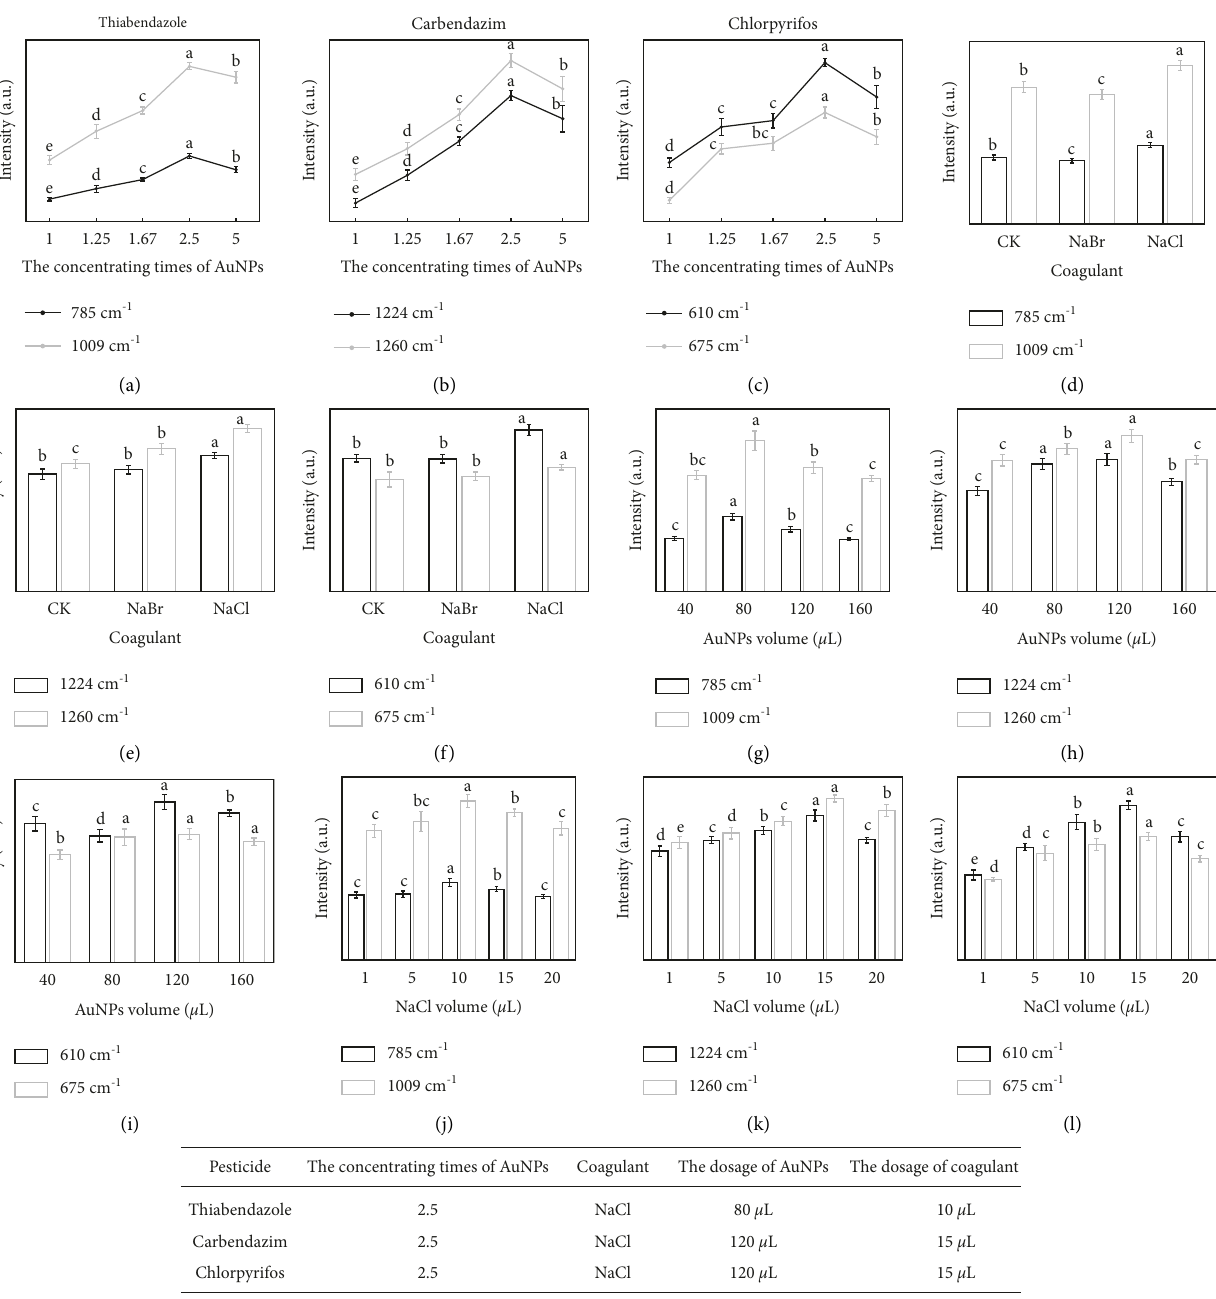
standard deviation of eight replicates. ±